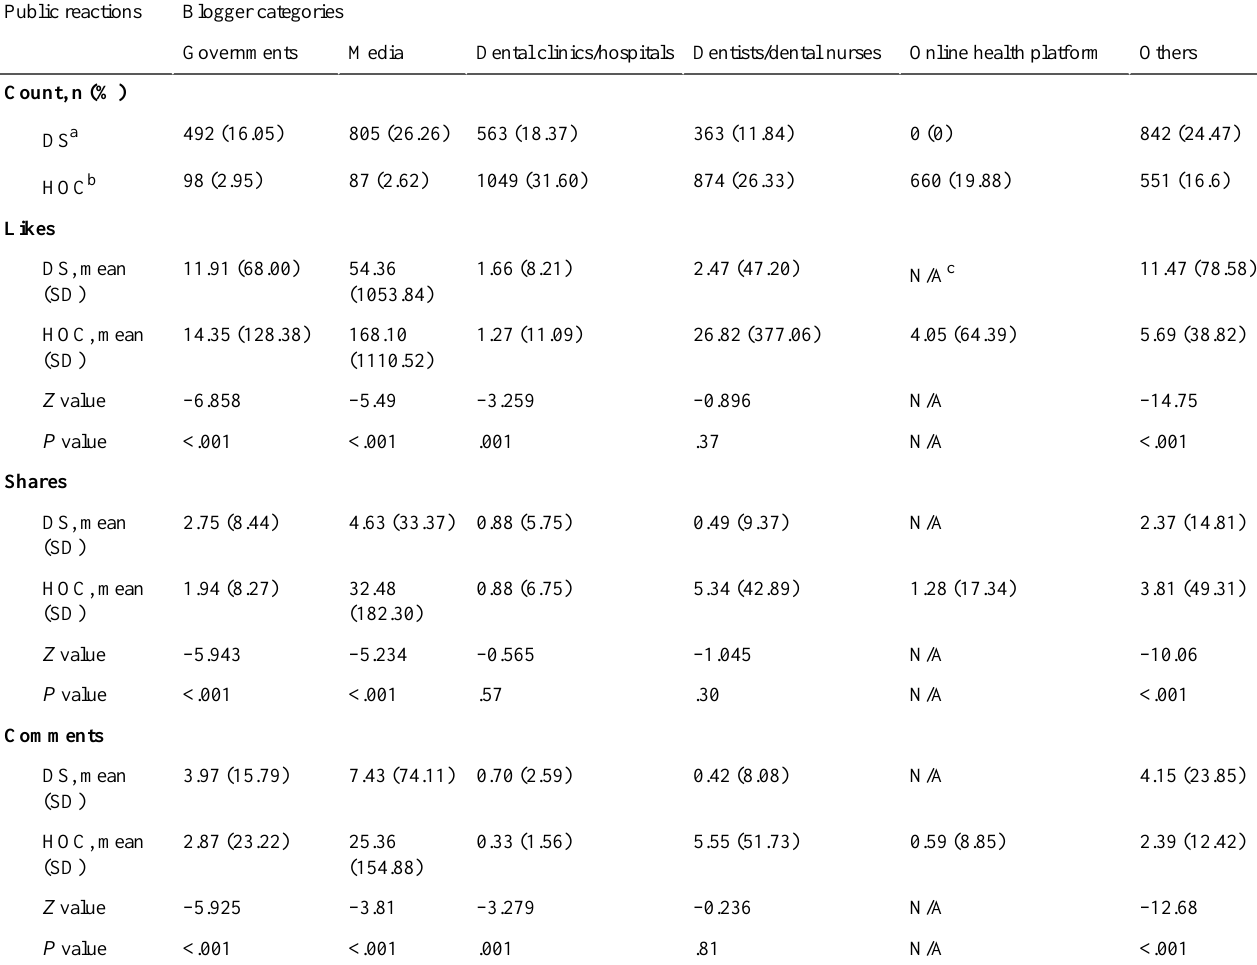
Table 3. Comparison of public reactions to tweets with dental services and home oral care information from different types of bloggers. Blogger categoriesPublic